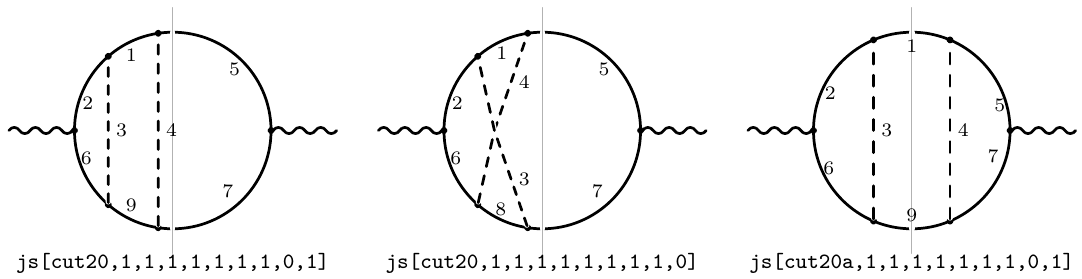
Figure 2 . Prototypes for master integrals of (2 , 0)